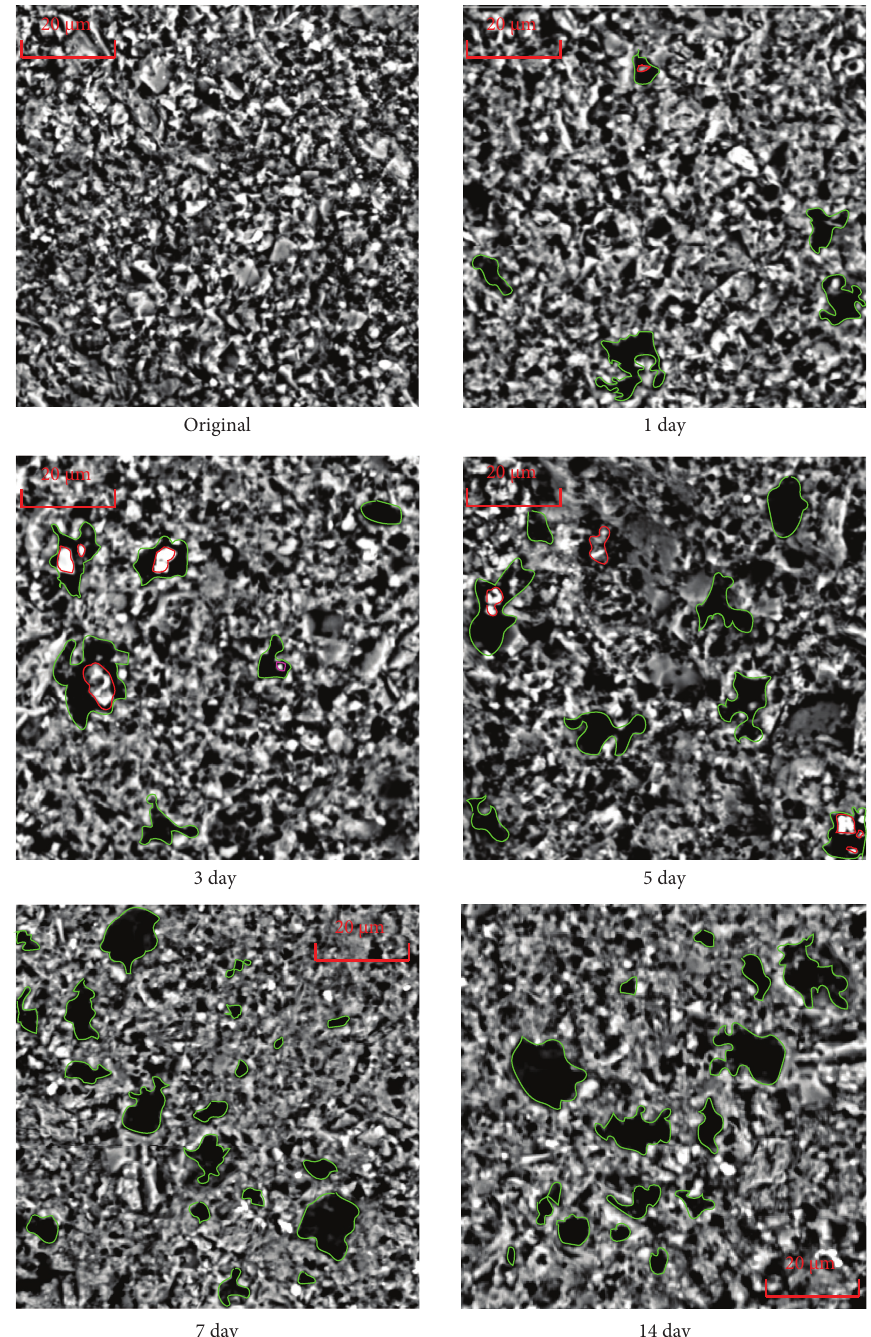
Figure 7: SEM images of shale fracture surfaces due to CO 2 soak. Green circles are pores that can be observed in the SEM